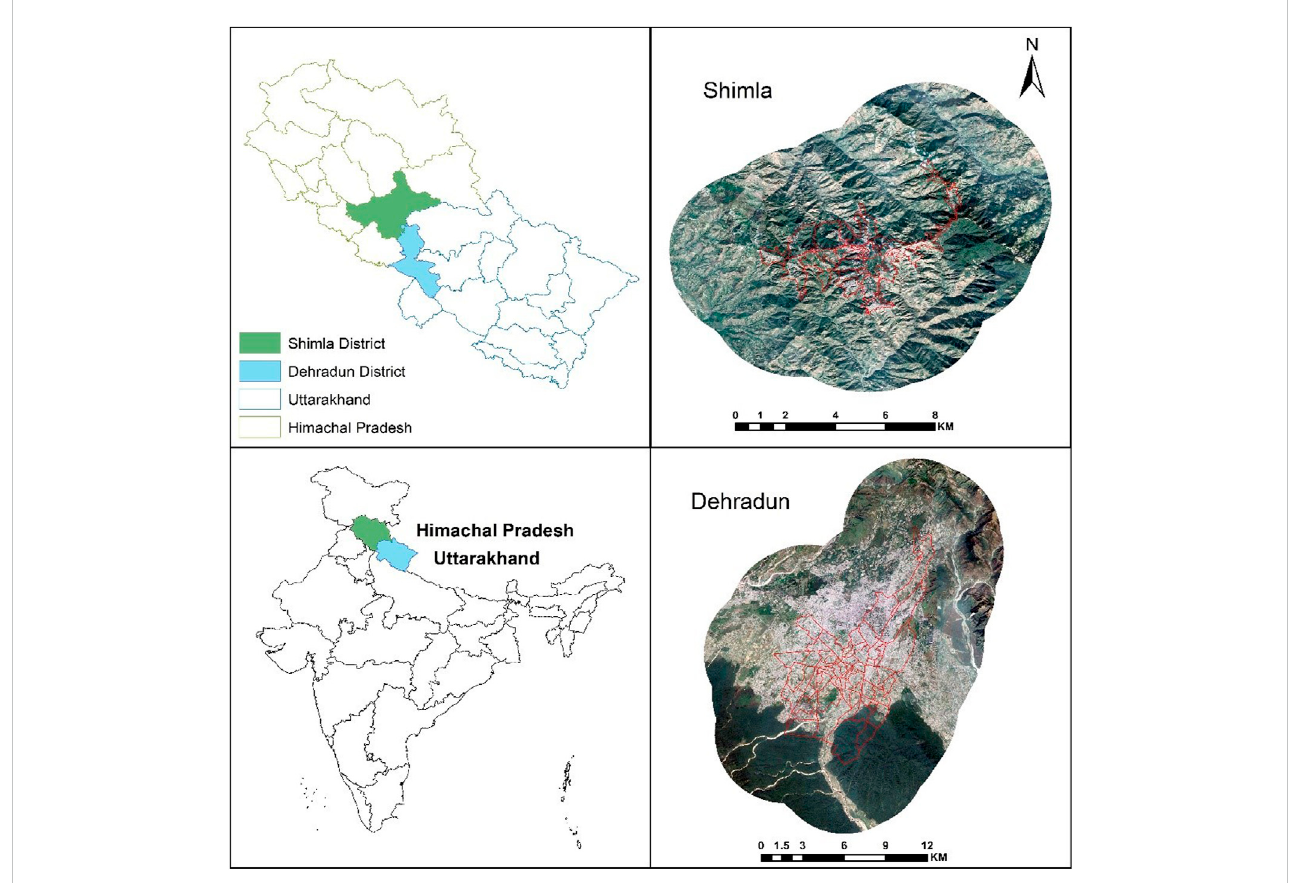
FIGURE 1 Study area location map with buffer zone of 5 Km.